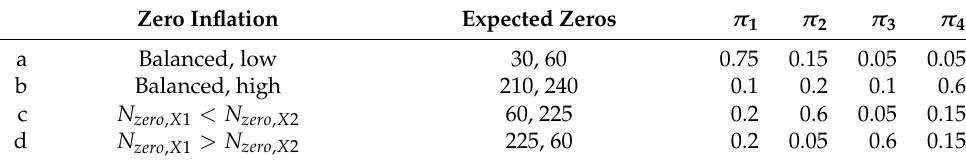
Table 2. Zero inflation parameters and resulting expected zeros for simulation of bivariate zero- inflated negative binomial vectors to represent pairs of metabolites and species (where X 1 represents a metabolite and X 2 represents a species) and pairs of species. Similar to the scenarios outlined in Table 1, there are balanced and unbalanced levels of zero inflation. The other BZINB model parameters are outlined in Appendix A Tables A1 and A2. The letter labels of each combination denote the zero inflation parameters used to obtain results for each line of Appendix A Table